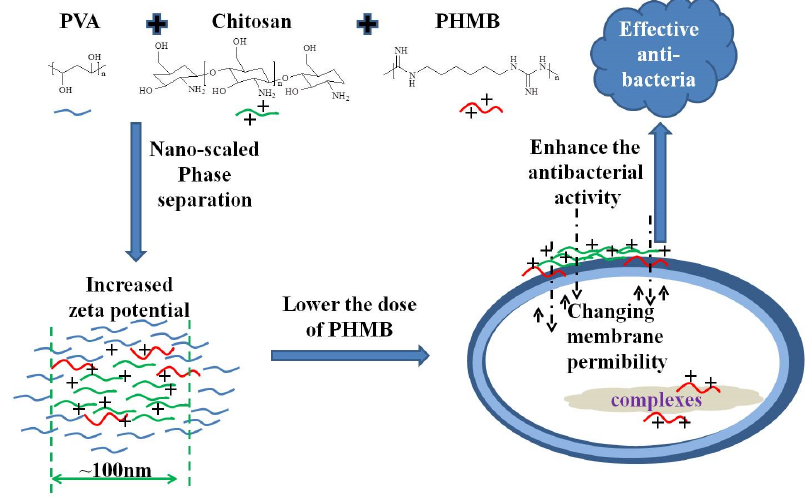
Figure 2. Photograph of minimum inhibitory concentration (MIC) of PHMB, PVA / PHMB, CHT / PHMB, PVA / CHT / PHMB in against ( a ) Staphylococcus aureus , and ( b ) Escherichia coli strains . Table 1. The data of MIC assay.